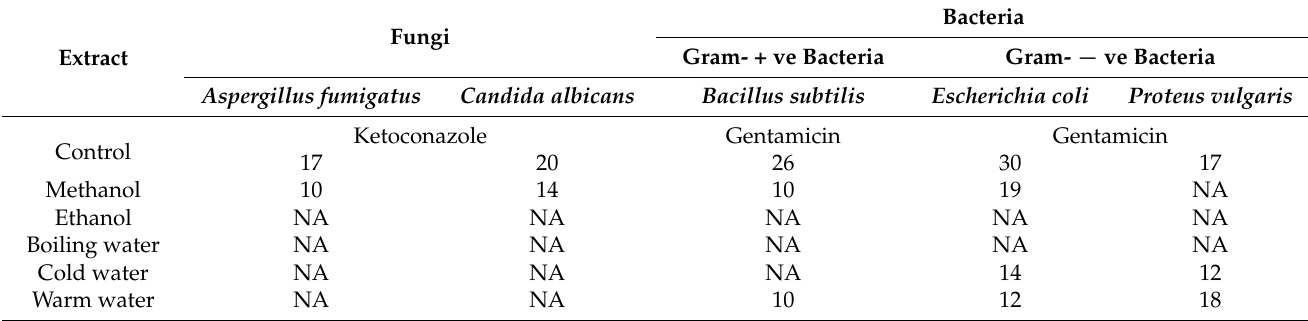
Table A3. Antimicrobial activity (mm) of the different extracts of Taif’s rose solid distillation wastes on the pathogenic fungal and bacterial strains. NA: no